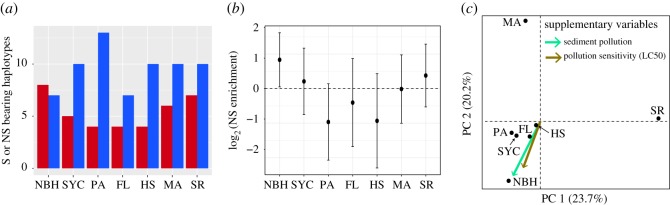
(a) Frequency of haplotypes bearing at least one non-synonymous SNP (NS; red bars), and haplotypes with only synonymous SNPs (S; blue bars), across all populations. (b) Relative enrichment (odds ratio) of NS relative to S across populations. (c) Principal component analysis in mtDNA haplotype frequencies. Sediment pollution (PCB126 sediment concentration; green arrow) and pollution sensitivity (LC50 to PCB126; brown arrow) were added into the PCA as supplementary variables.